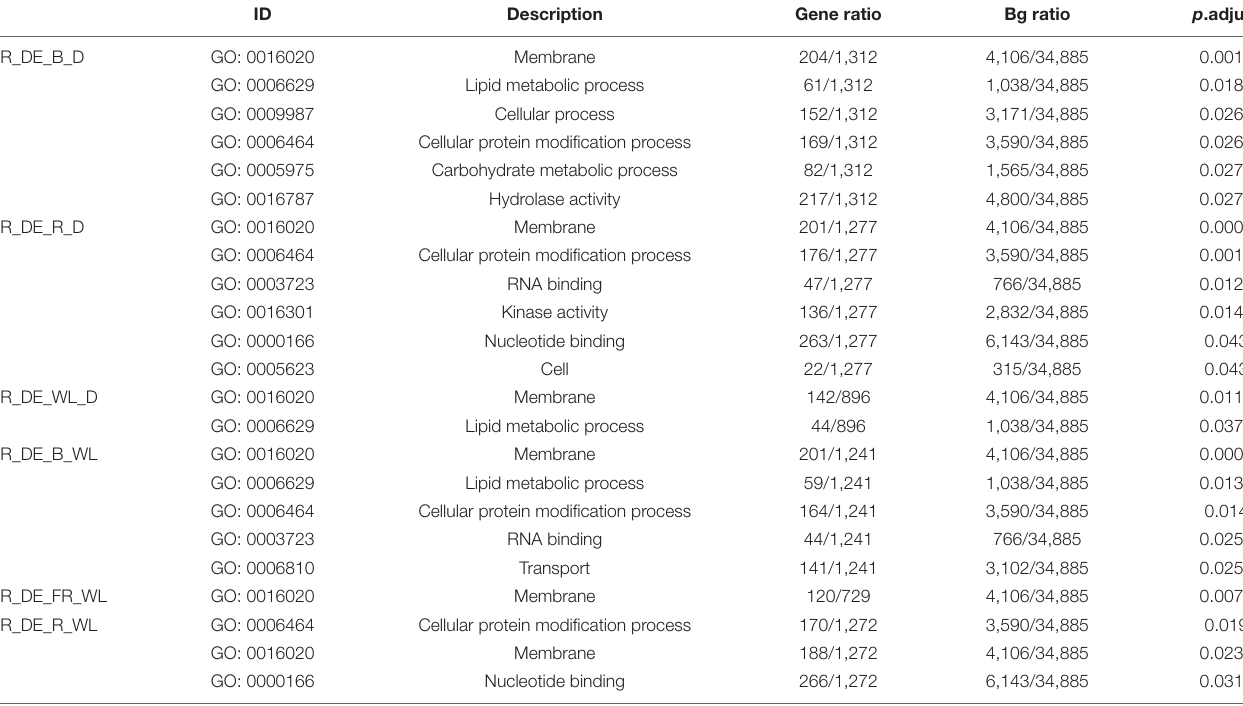
TABLE 3 | Gene ontology (GO) functional enrichment of differentially expressed IR isoforms. ID Description Gene ratio Bg ratio p